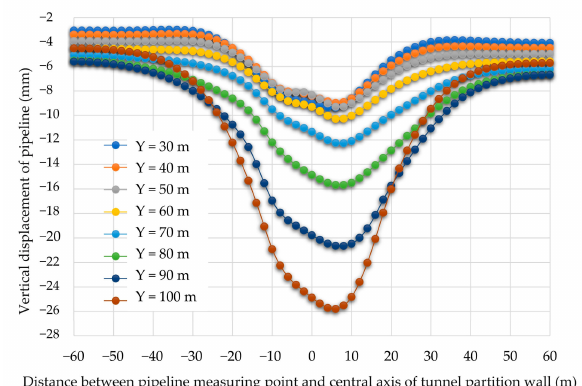
Figure 22. Vertical deformation of underground